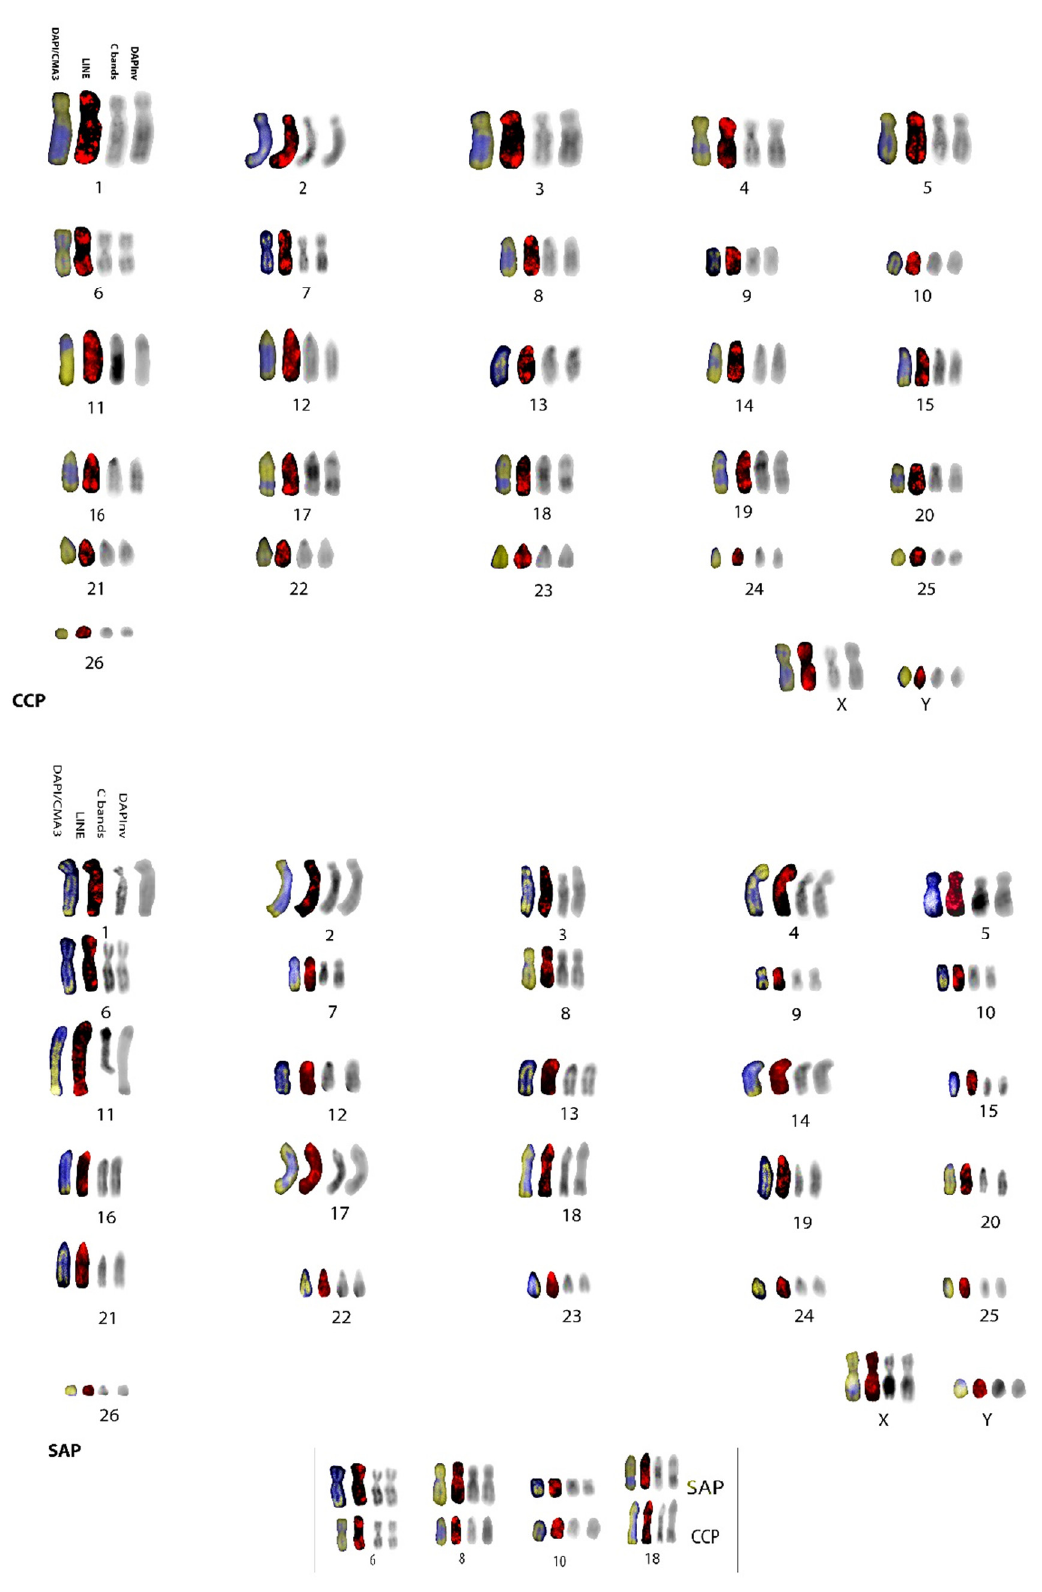
Figure 2. Haploid karyotypes of C. capucinus (CCP) and S. apella (SAP), from left: chromosomes with DAPI staining (blue) and CMA3 (yellow) overlapped; LINE probe signals (red); C bands; inverted DAPI (black and white). Note in the box chromosomes 6, 8, and 10 differently due to inversions in SAP and CCP; additionally, pair 18 has different patterns of both C bands and LINE-1